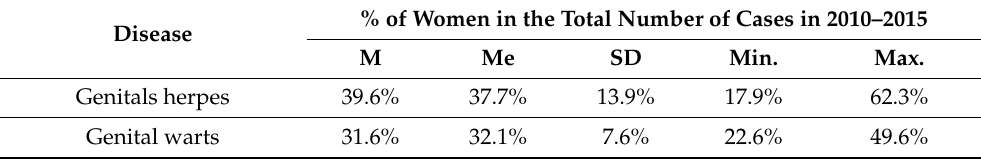
Table 5. Summary incidence for diseases included in the analysis in the female